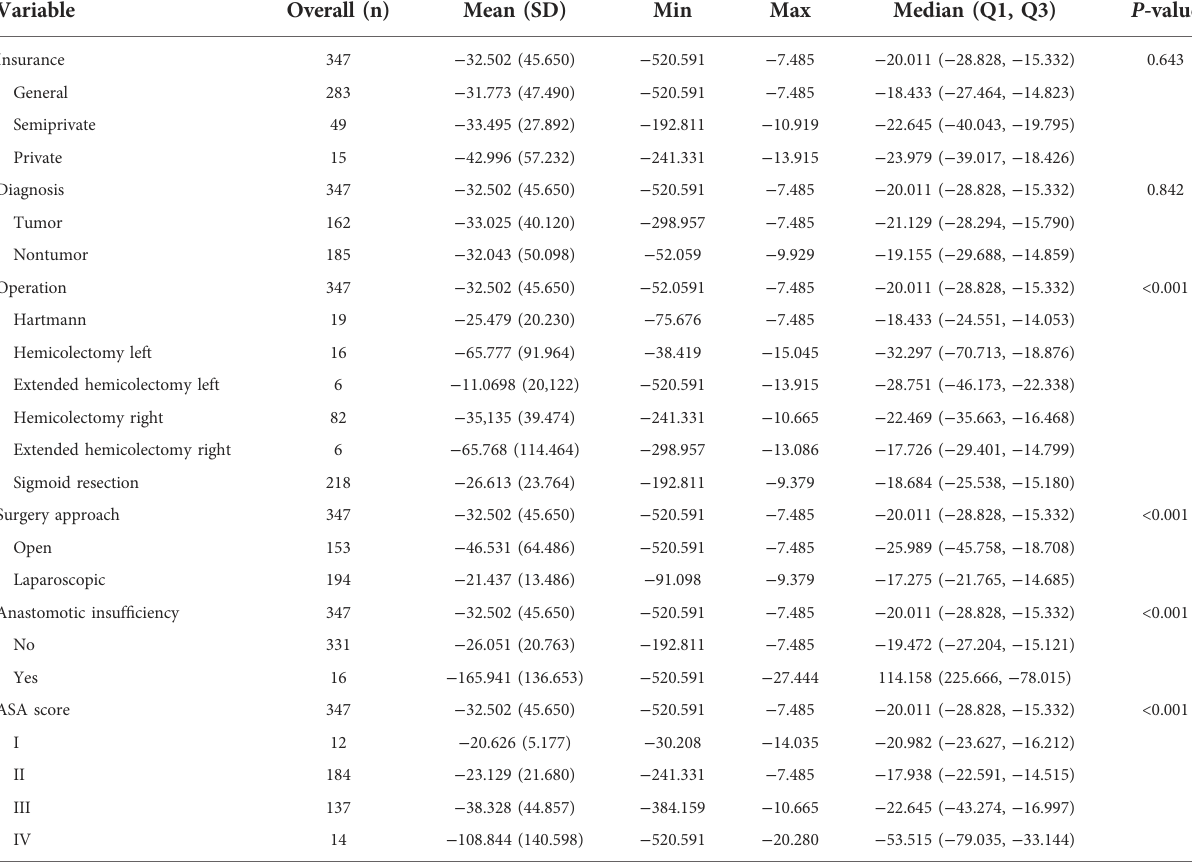
TABLE 3 Descriptive statistics based on fi nal costs.